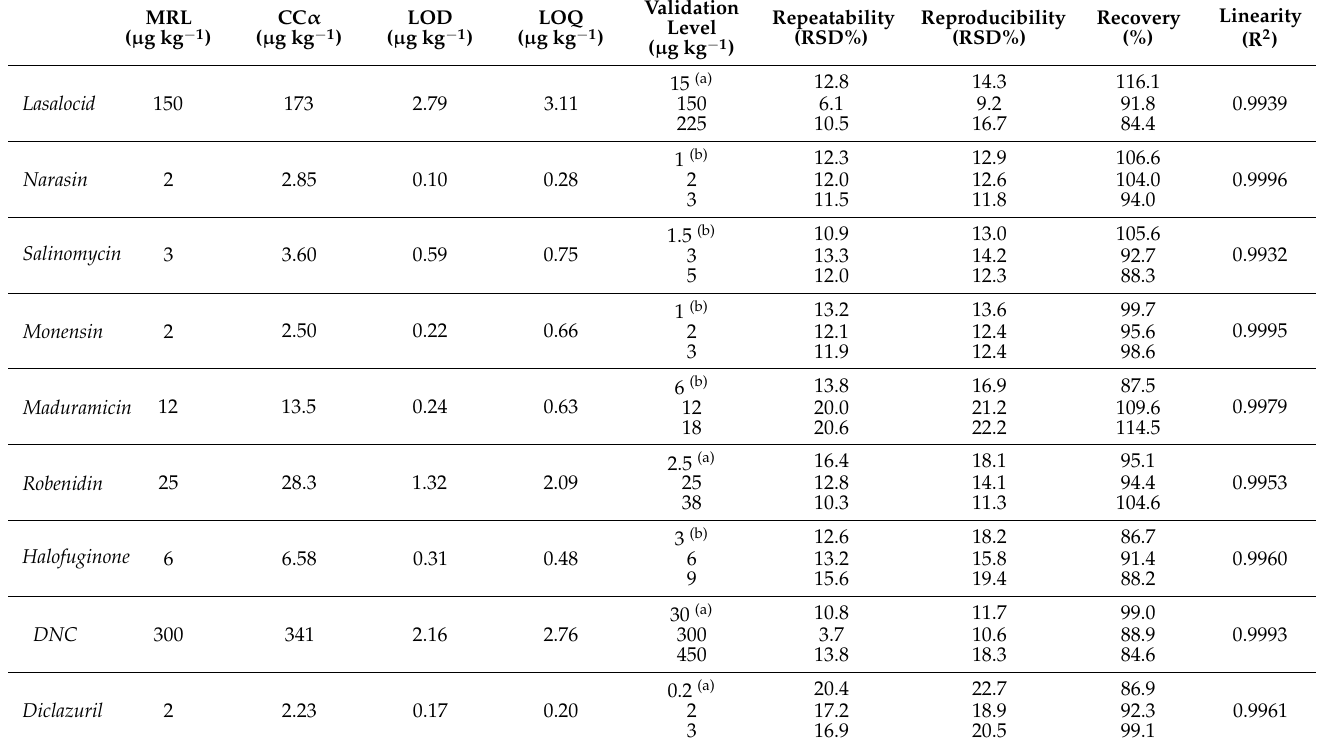
Table 2. Summary of validation